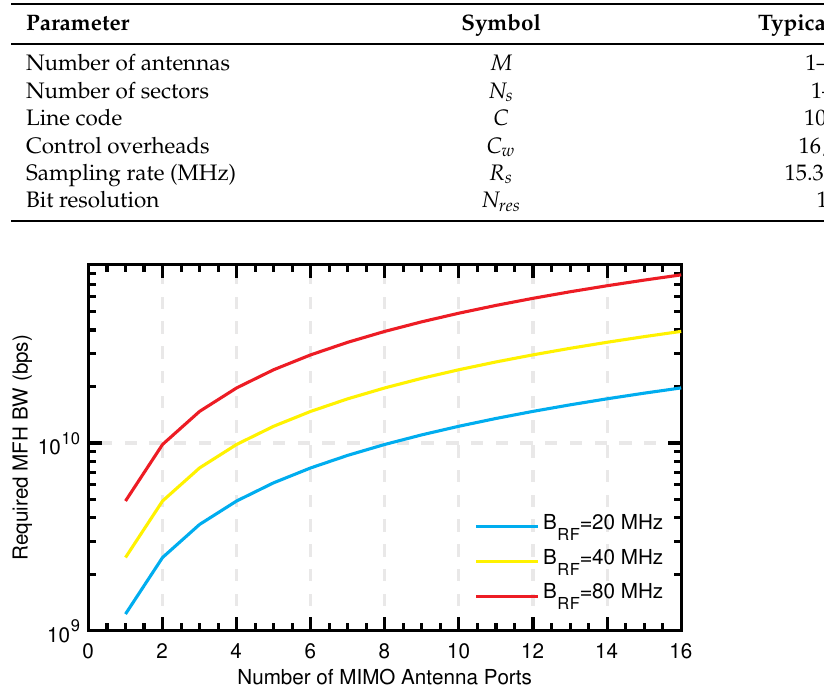
Figure 26. Required MFH capacity for supporting different RF bandwidths ( B RF )